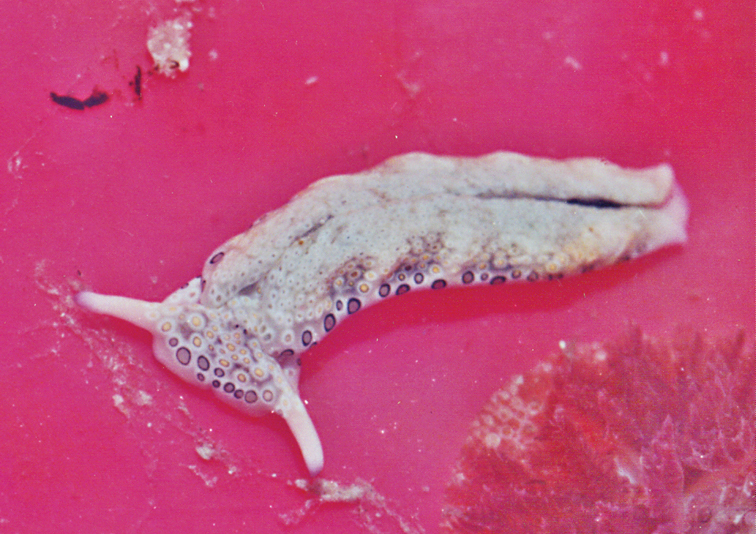
Plakobranchus ocellatus, 14 mm pres., Zanzibar, photo: MD Richmond.